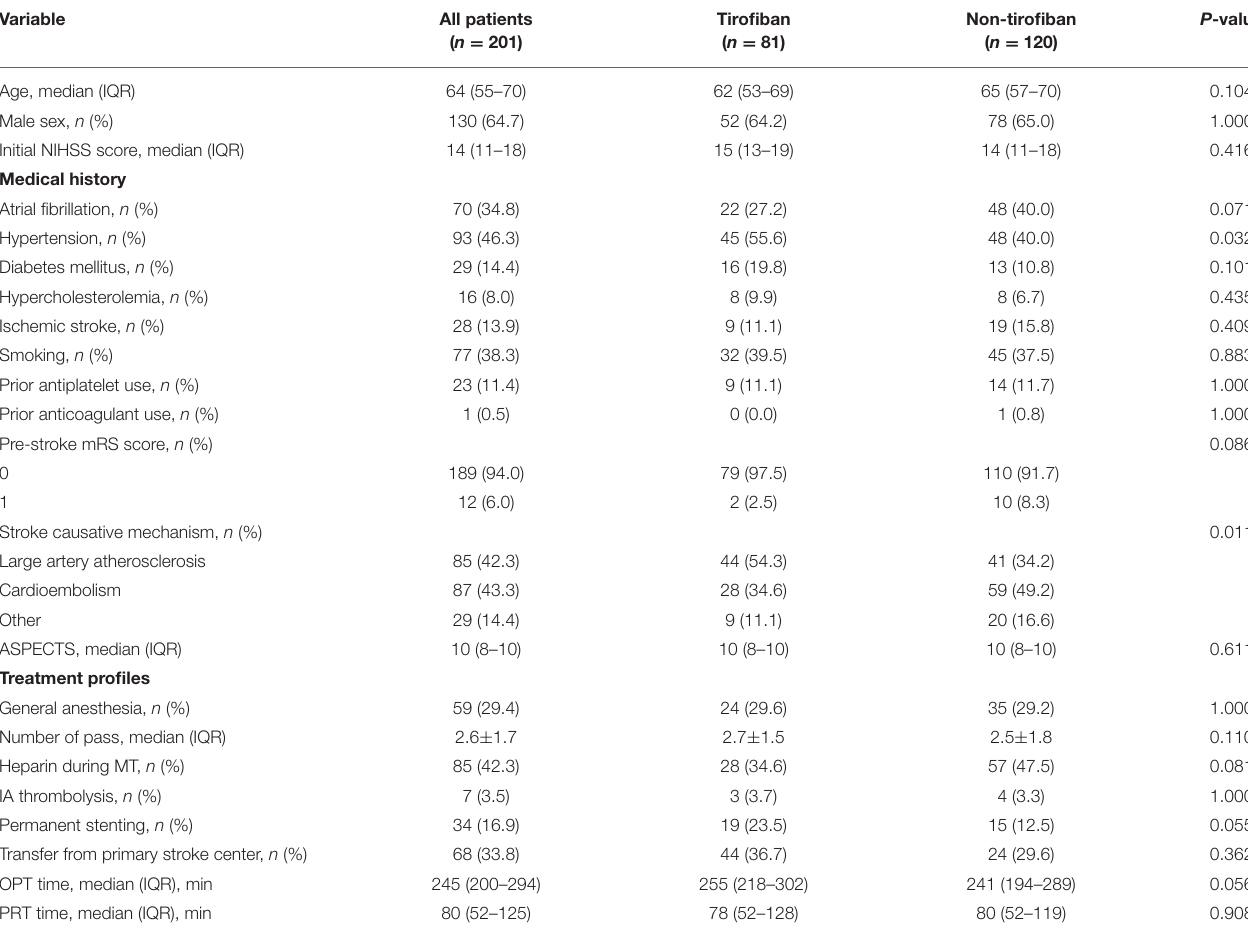
TABLE 1 | Baseline characteristics of patients before PSM.